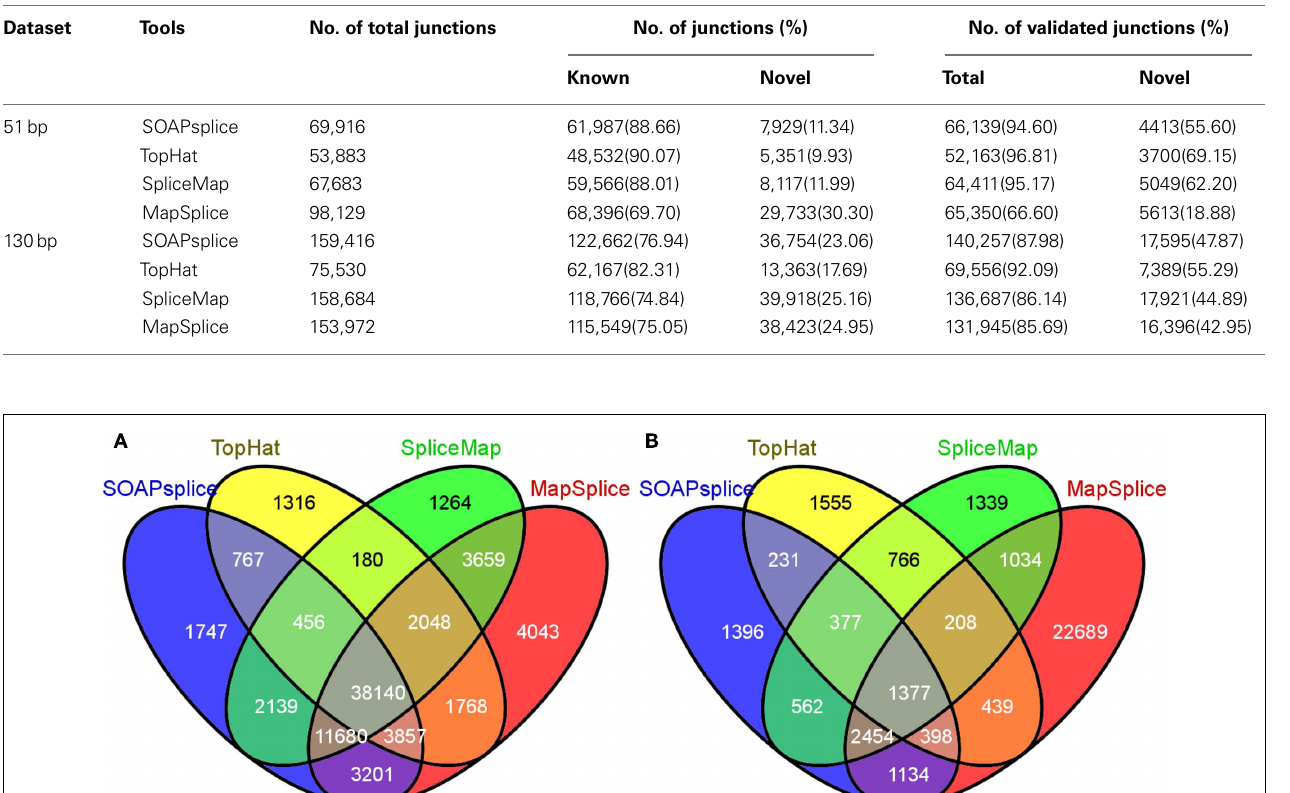
Table 1 | Number of junctions detected on the real datasets.